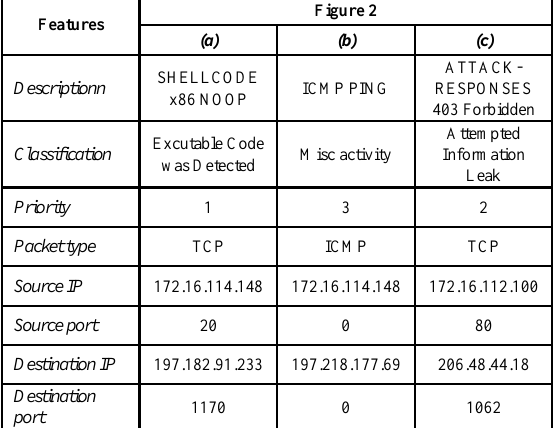
Fig. 3. Feature Selection for Snort